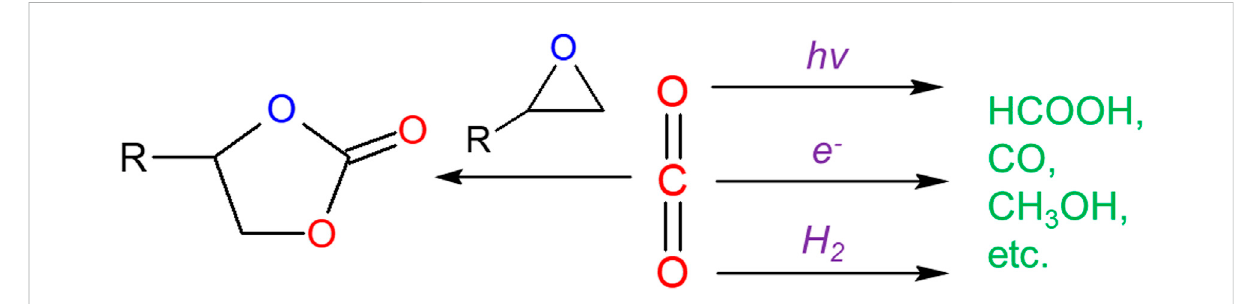
FIGURE 1 Main routes of CO 2 conversion into value-added chemicals and fuels.